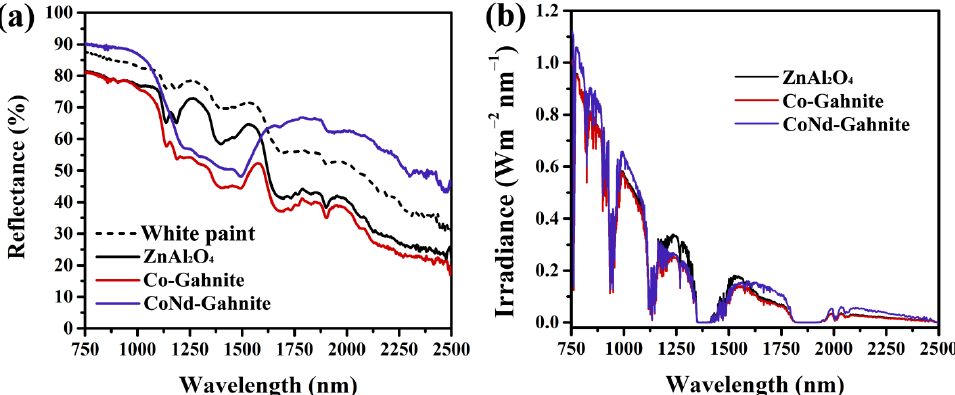
Figure 7 . ( a ) Diffuse reflectance spectra of the synthesized pigments dispersed in white commercial paint; and ( b ) NIR solar reflectance spectrum of the coatings adjusted to the standard solar spectrum.